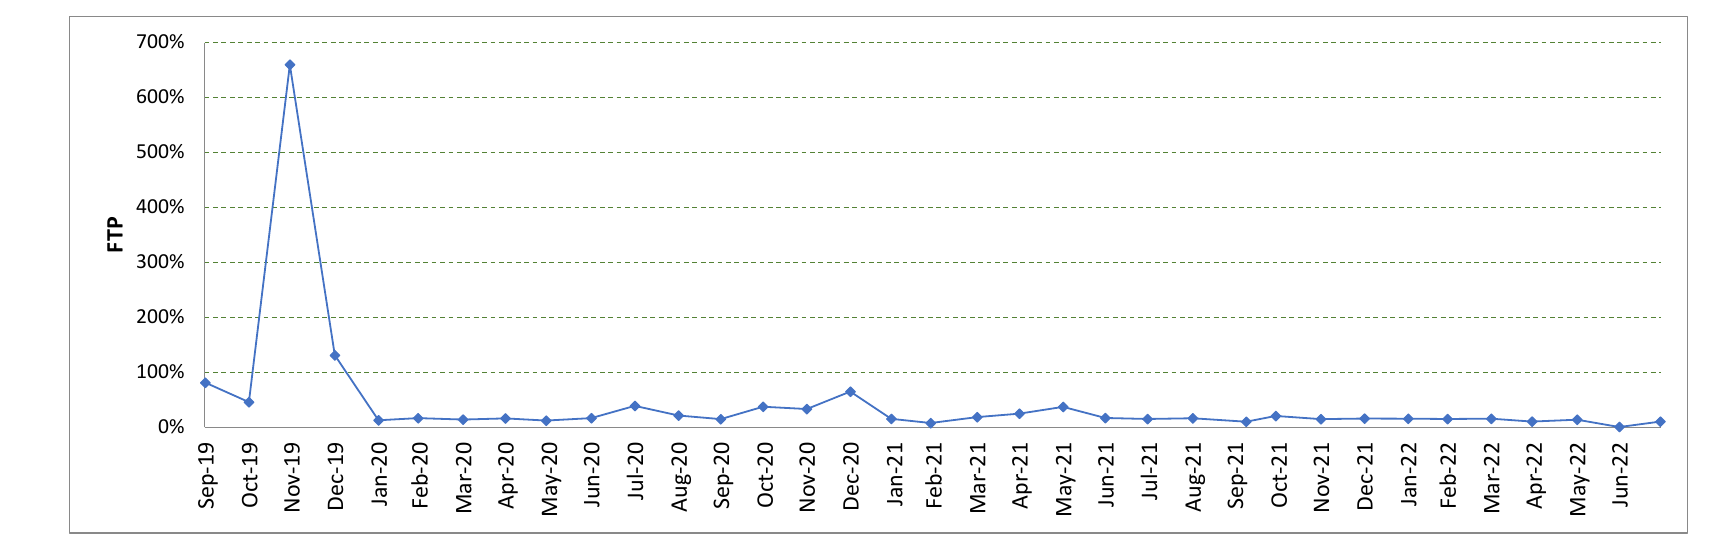
Figure 10. Minimum-turbulence-adjusted portfolio.